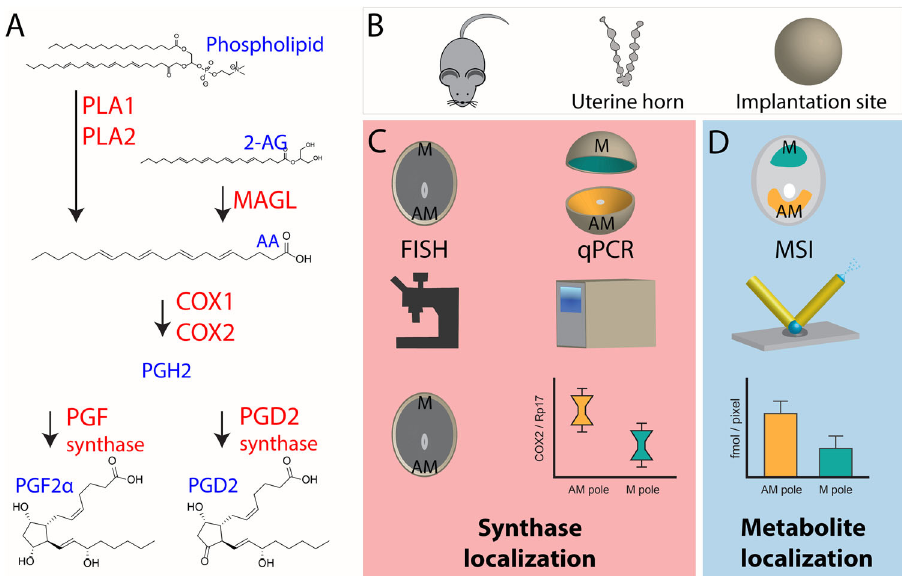
Fig. 1 Schematic detailing the studied PG biosynthesis pathway and experimental design. A Generation of PG species from phospholipids or 2-AG via COX and PG synthases, enzymes are in red and metabolites in blue. B Mouse embryo implantation sites from day 8 of pregnancy were used from Trp53 f/f and Trp53 d/d mice. C Florescence in situ hybridization was applied to study the in situ localization of synthases. Implantation sites were segmented into the AM-pole and the M-pole for RT-qPCR analysis of enzyme mRNA expression. D Quantitative nano-DESI MSI was performed on thin sections of implantation sites to determine in situ small molecule